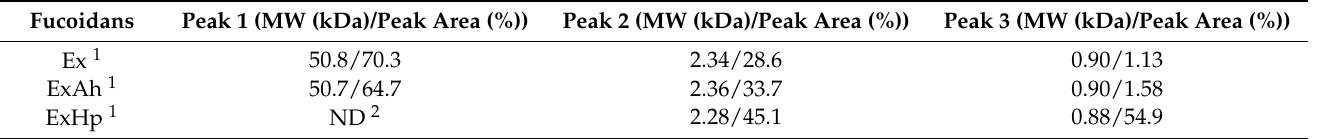
Table 3. Molecular weight analysis for Ex, ExAh, and